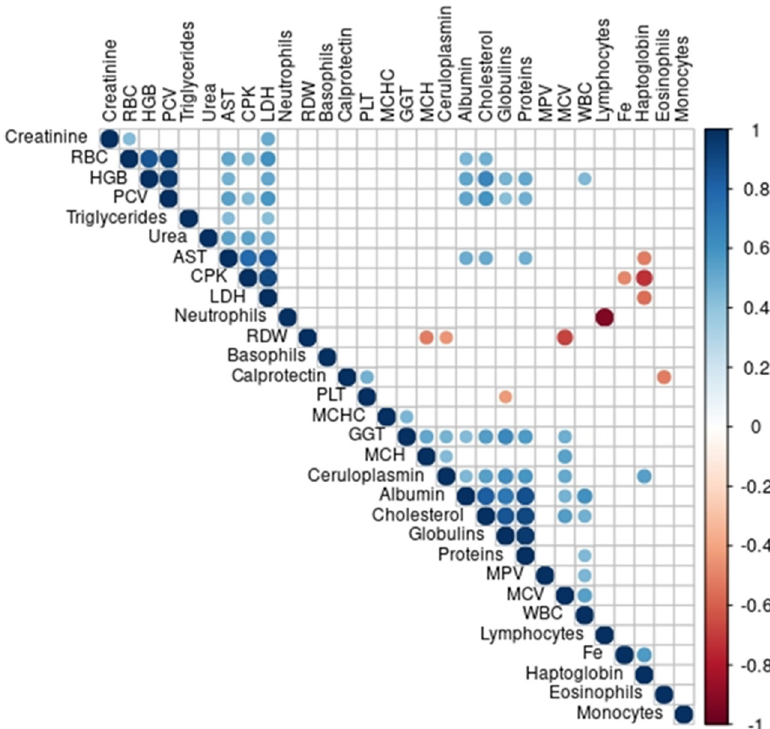
Figure 4. Correlations of changes in acute phase biomarkers, and haematological and biochemical parameters in 23 horses, shown by correlogram. Only statistically significant correlations ( p < 0.05) were shown using a correlation coefficient ranging from − 1 to 1, in colour, where blue indicates linear positive correlations, while red indicates negative linear correlations. The strength of the correlation increases with an increase in the size of the circle and the intensity of the colour.